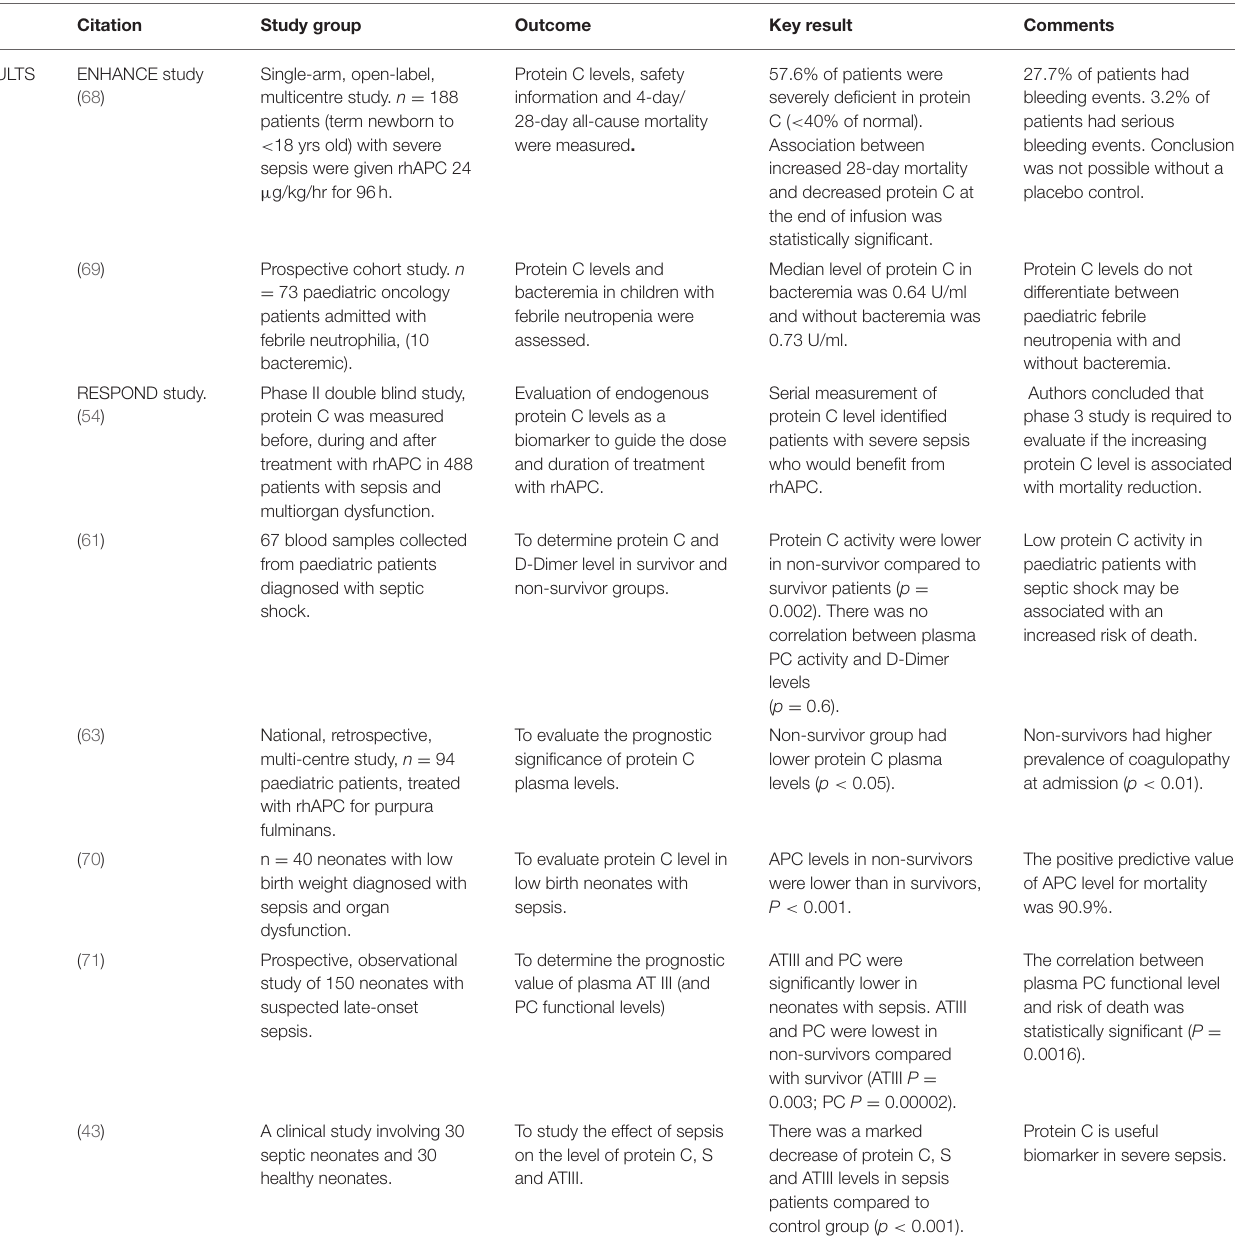
TABLE 2 | Protein C as a biomarker of